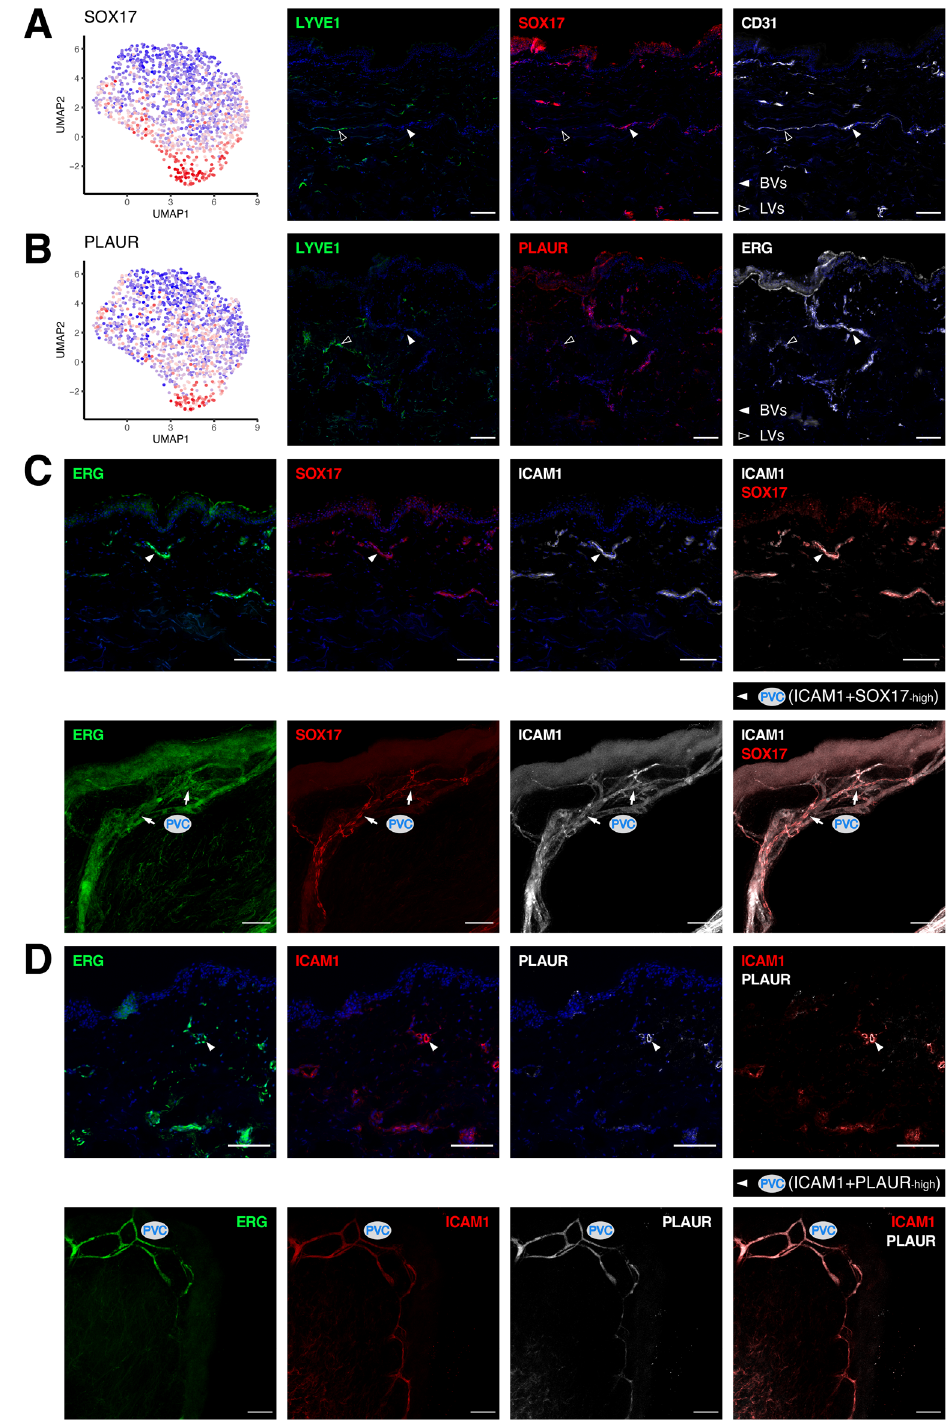
Figure 5. Pre-venular capillaries are pinpointed by novel markers. Specific localization of the PVC markers SOX17 ( A ) and PLAUR ( B ) in human dermal BVs (white arrowheads). ( C ) Intersection of ICAM1 (white) and SOX17 (red) highlights the segments of pre-venular capillaries. ( D ) Co-staining of ICAM1 (red) and PLAUR (white) in skin sections (upper) and whole-mount skin blocks (lower) denotes the pre-venular capillary cluster. Scale bars: 100 µm.